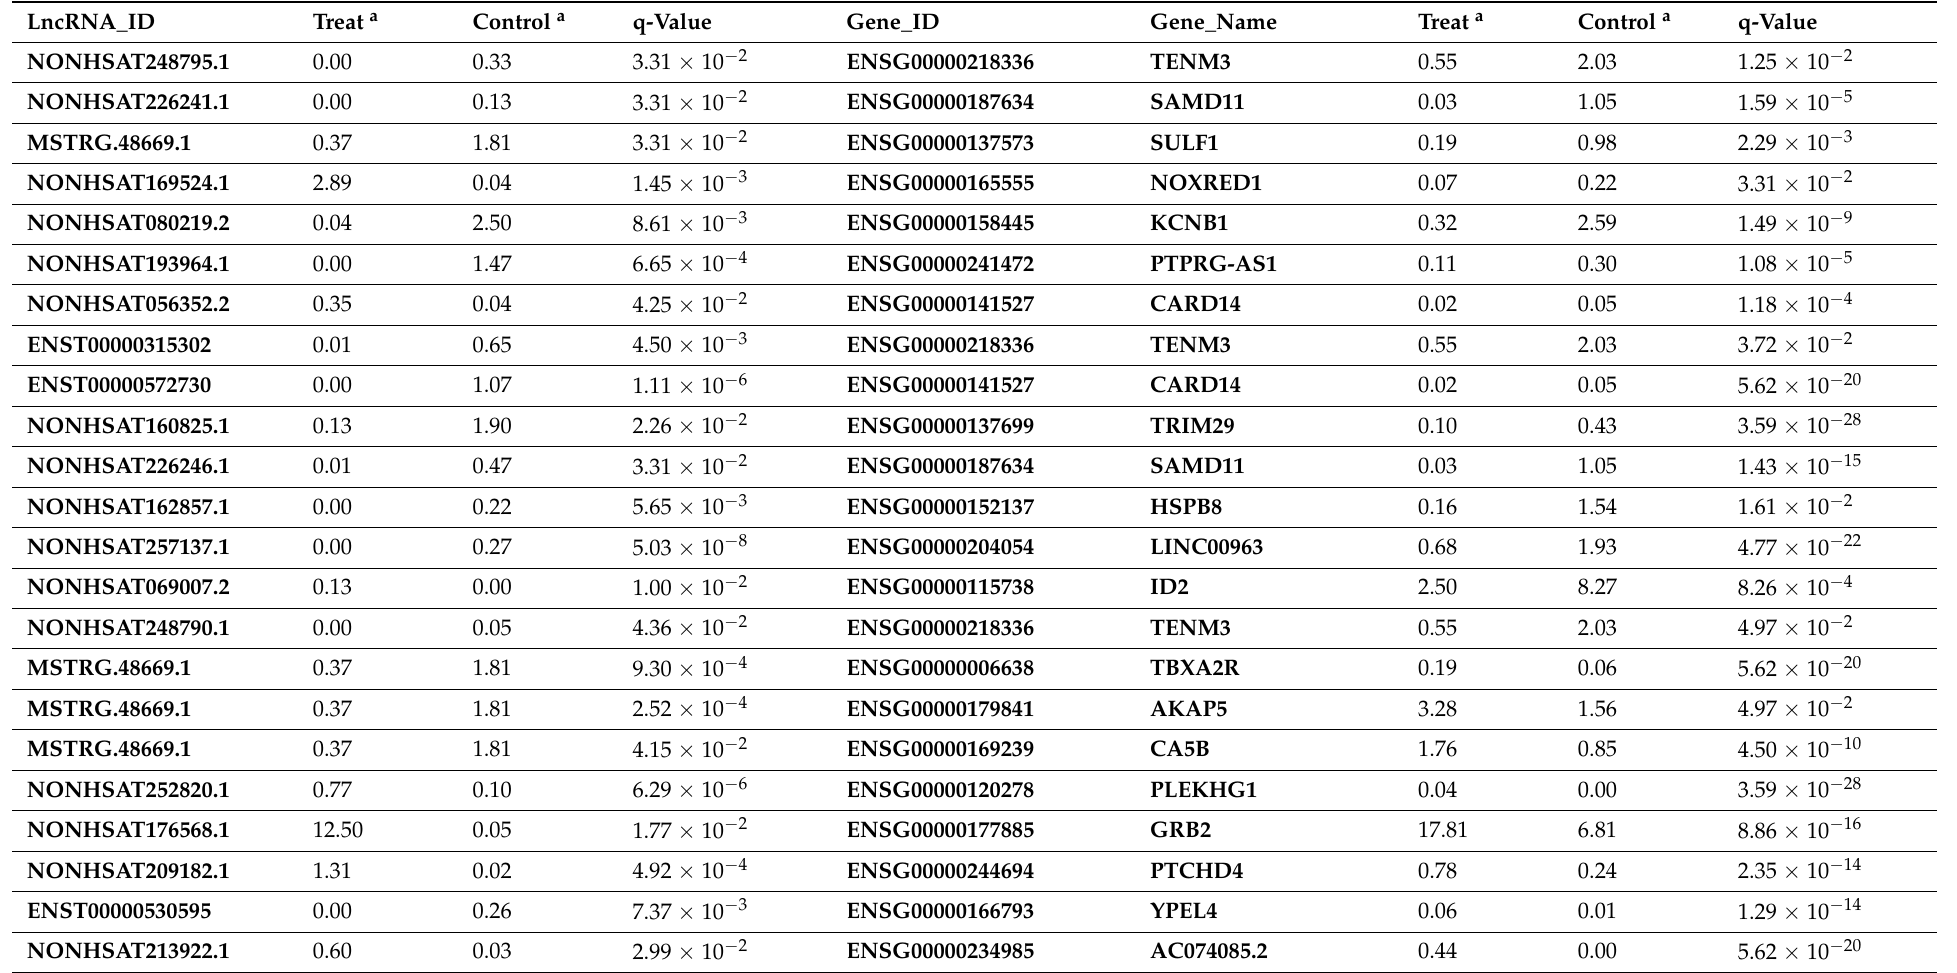
Table 2. The target genes of the differentially expressed lncRNAs intersected with those of the